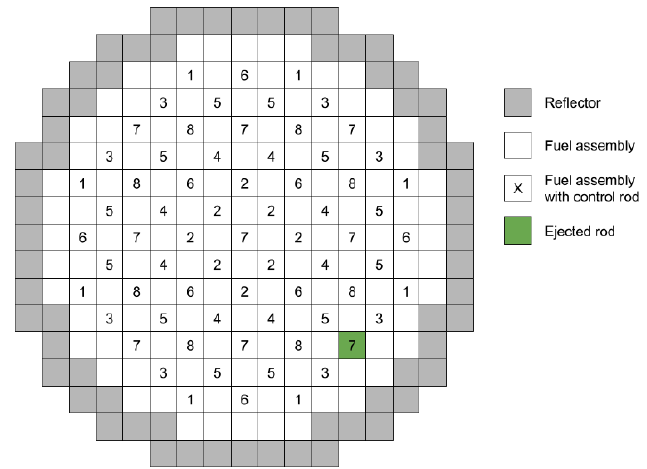
Figure 1: TMI Core (Hou et al,